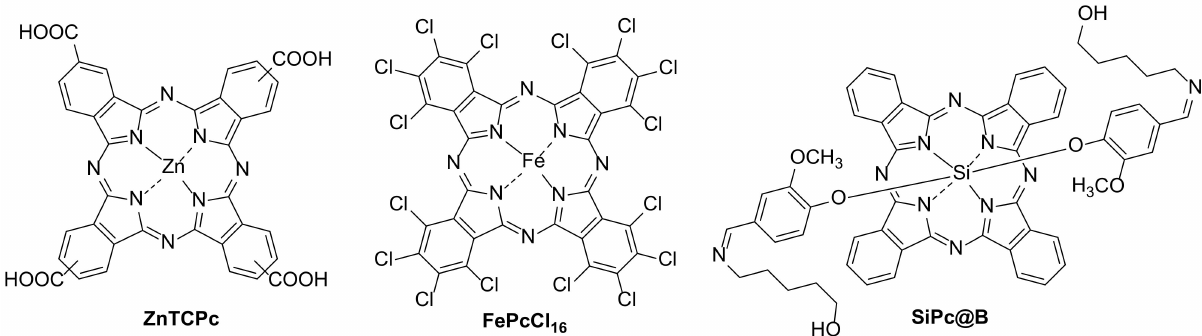
Figure 10. Structures of tetrapyrrolic macrocycles (TPM) mostly used as catalysts for degradation of carbamazepine. Table 5. Photochemical degradation of neurologic pharmaceuticals using TPM-based catalysts. #/Ref Drug Experimental